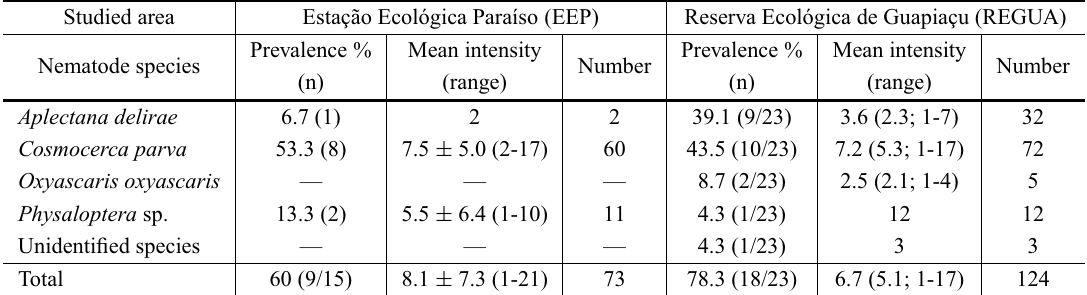
Prevalence (in percentage and absolute values), mean intensity of infection ( ± SD, with range in parenthesis) and number (quantity) of nematodes found in Proceratophrys boiei (N = 38) in EEEP and REGUA, two Atlantic rainforest remnants in the State of Rio de Janeiro. (a = found in the stomachs, b = found in the intestines and c = found in the